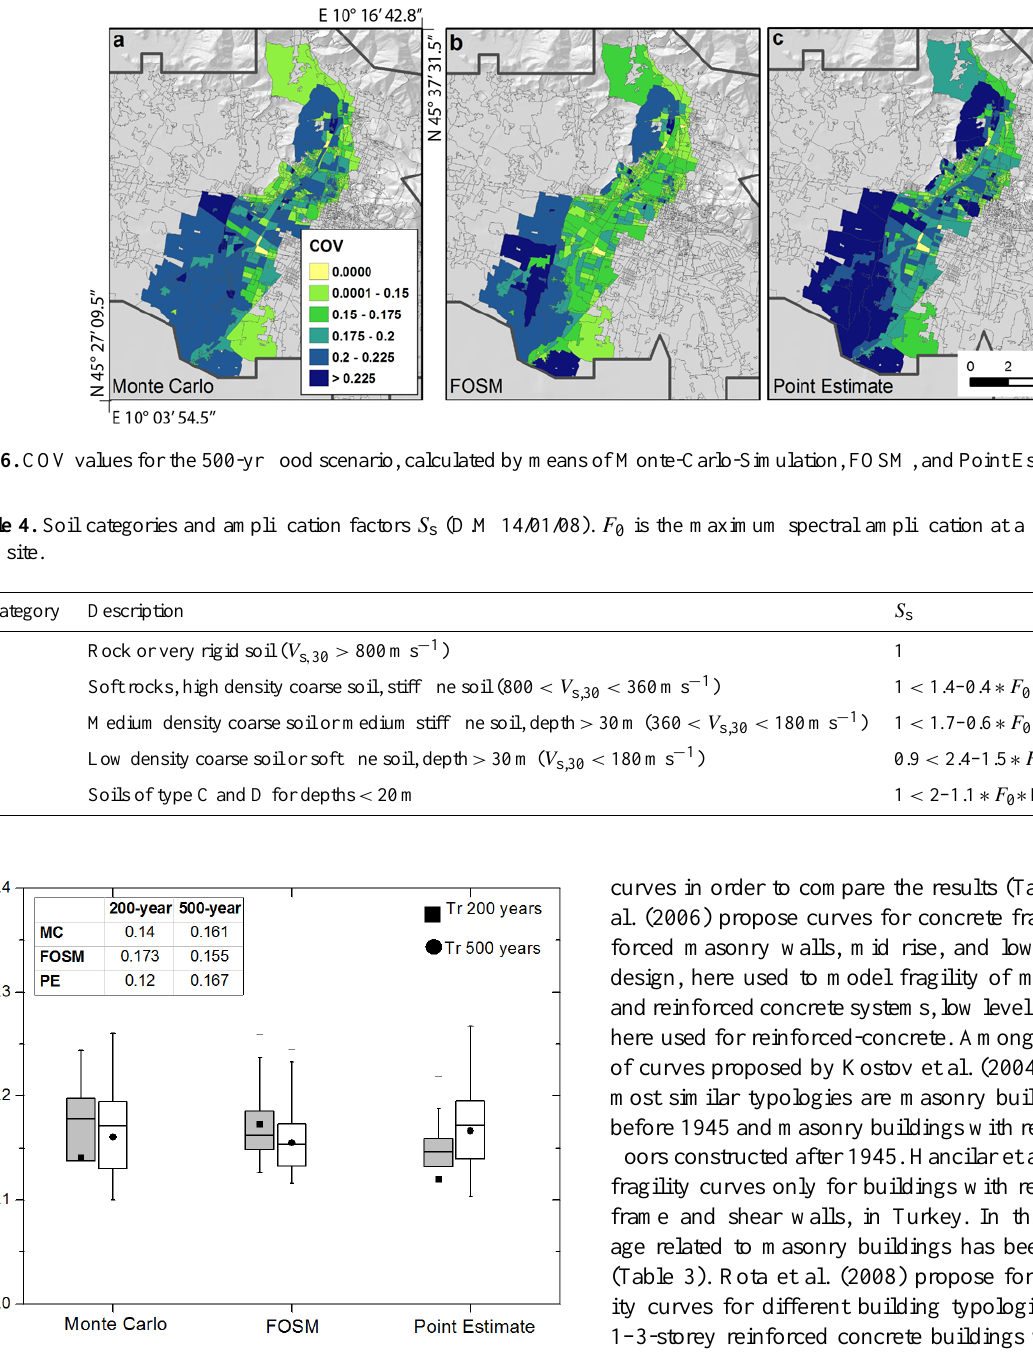
Fig. 7. COV values for flood scenarios, obtained by means of MC, FOSM and PE approach. Box plot indicates the mean value (point), the 25, 75 percentiles and the median (box), 5 and 95 percentile (vertical lines). The mean values are shown in the